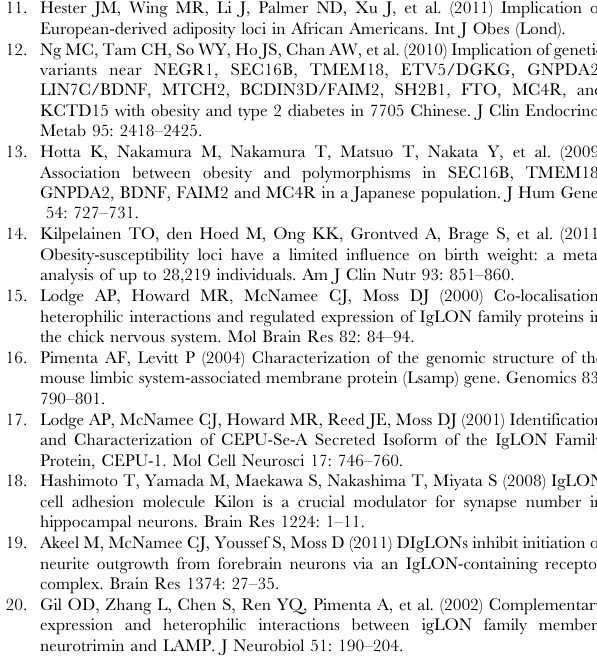
Figure S4 Mixed graphical model for data collected at time point 16 weeks of Negr1 -I87N study. Conditional dependence between variables (shown as vertices in the graph) is represented by the edges in the graph, so, for example, ‘‘X and Y are conditionally independent given Z,’’ is represented by the graphical property ‘‘all paths joining X and Y pass through Z.’’ See Methods and [58,59] for further details. Figure S5 Hypothalamic Negr1 expression is unaffected by fasting. A. Absence of NEGR1 expression in peripheral tissues. Blots were probed with antibodies specific to NEGR1 ( , 50 kDa, upper panel) and a -actin (43 kDa, lower panel). The protein band in muscle represents a , 45 kDa non-NEGR1-